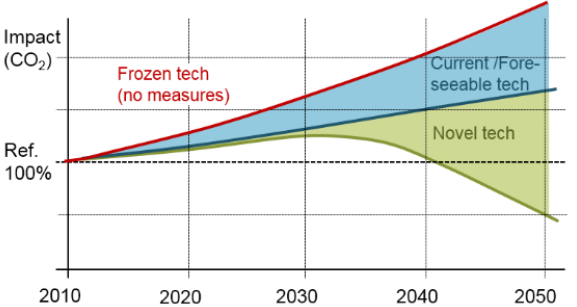
Figure 1. Forecast of CO 2 emission impact due to increased transportation and emission reduction goals